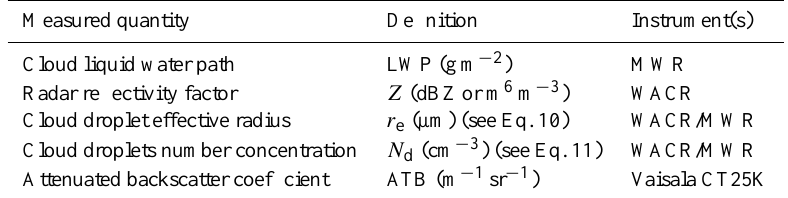
Table 1. Cloud and aerosol properties measured or derived from the observations at the Graciosa Island, Azores. Measured quantity